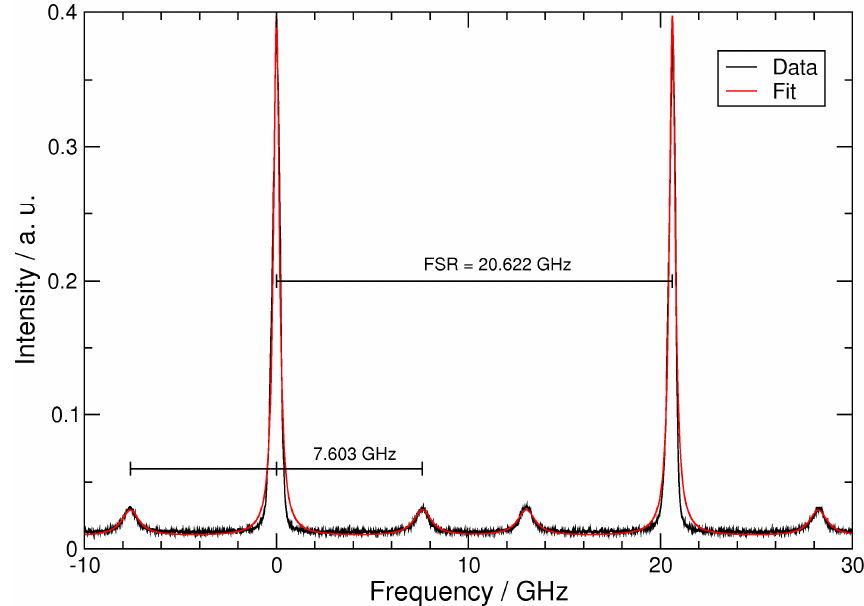
Figure 4. Measured Brillouin spectrum for a water temperature of 33.6 ±0.2 °C. The frequency shift resulting from the fitting procedure is 7.603 ±0.015